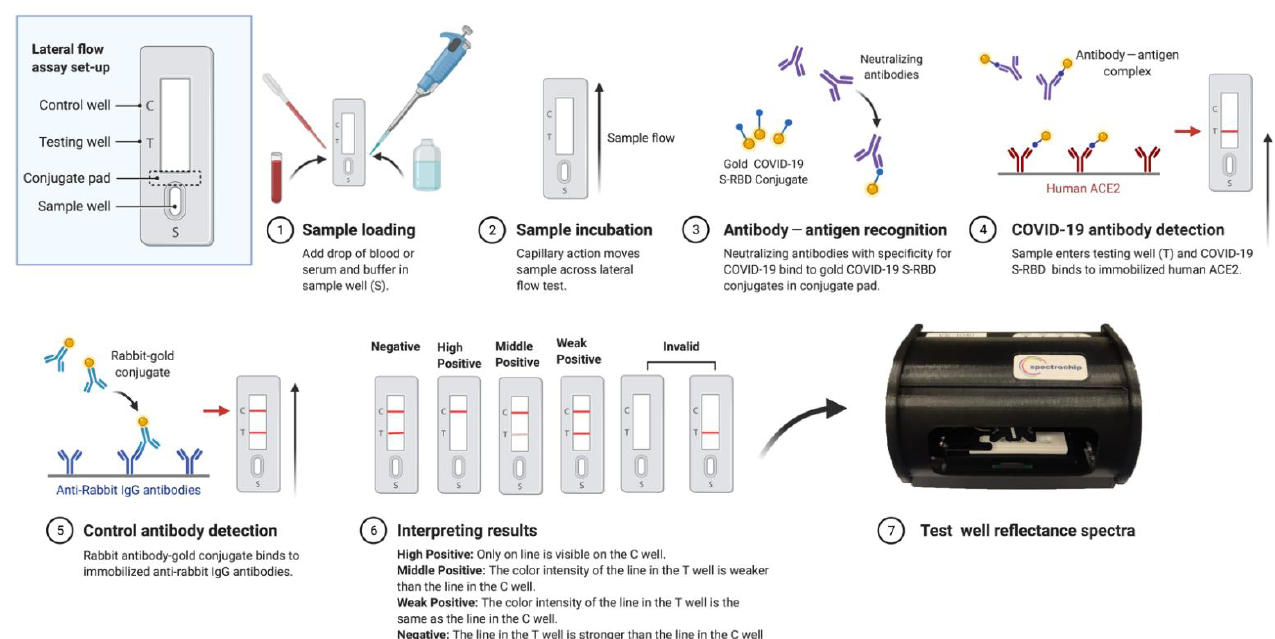
Figure 1. SARS-CoV-2 Neutralizing Antibody Rapid Test Cassette workflow coupled with a spectrum- based reader. This newly quantitative system required 60 µ L of serum and 40 µ L of dilution buffer to be added to the lateral flow immunoassay and provided results in 10 min. The test cassette was placed inside a spectrum analyzer for the quantitative spectral analysis. This scan took approximately three minutes to complete. Automatic scanning of the rapid test cassette was activated with software. Full-spectrum antibody reflex optical signals were acquired from the spectral optical mod- ule to analyze the neutralizing antibody full-spectrum distribution and concentration.